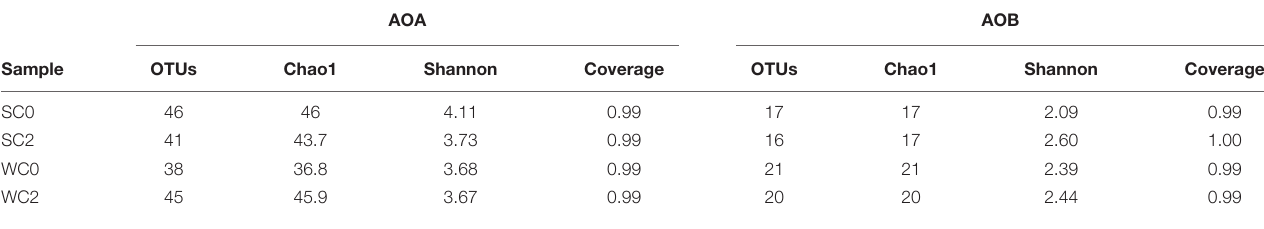
TABLE 2 | Richness indices, diversity indices and Good’s coverage of the AOA and AOB